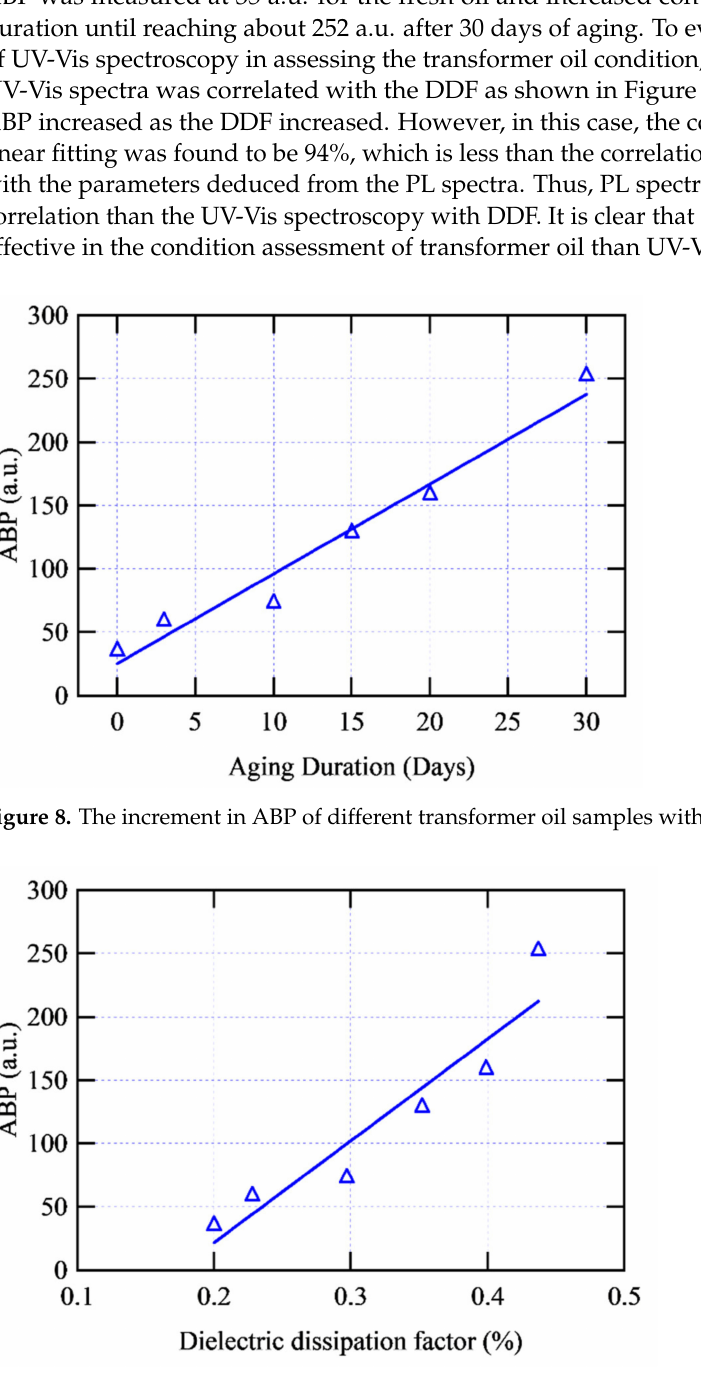
Figure 9. Correlation of ABP deduced from UV-Vis absorption spectra with